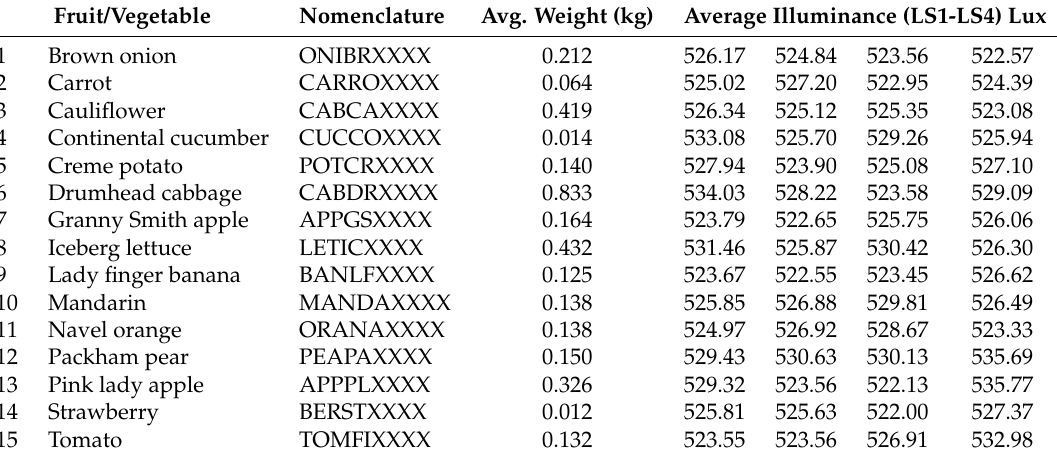
Table 3. A description of the classes in the obtained dataset, nomenclature, and illuminance values obtained with sensors (LS1–LS4).